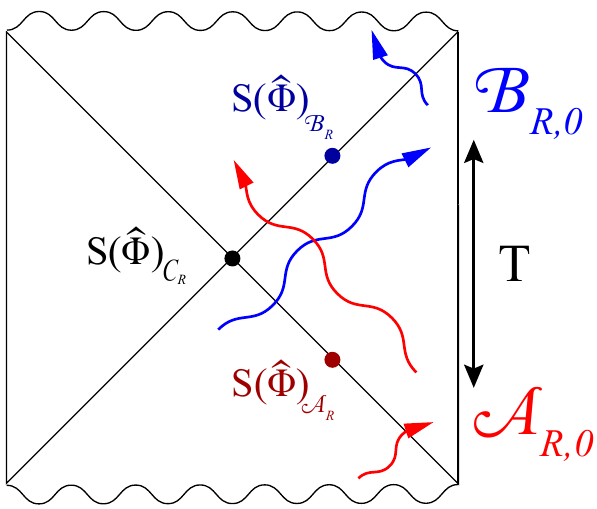
Figure 4 . The large N algebra C R, 0 is generated by the isomorphic and commuting algebras A R, 0 and B R, 0 which describe early and late time excitations respectively. The two algebras are separated by a time T , which diverges at large N such that β (cid:28) T (cid:28) t scr . The generalized entropy of the bifurcation surface computes the entropy S ( b Φ) C of the Type II algebra C R generated by C R, 0 and h R , R while the generalized entropies of the white and black hole horizons, at intermediate times between the two sets of modes (marked by the indicated cuts of the future and past horizons), compute respectively the entropies of algebras A R and B R (generated by h R and either A R, 0 or B R, 0 ). state | Ψ i | Ψ i ∈ H . In close analogy to section 2.1, the algebras A and B C R, 0 R, 0 A B